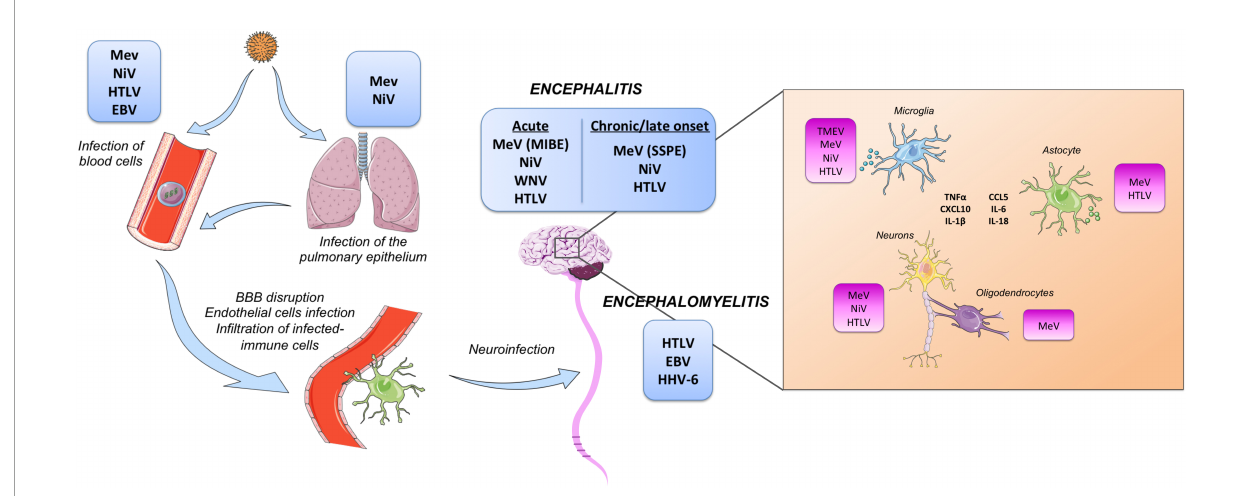
FIGURE1 Graphical representation of viral-induced neuroinflammation. (Left) Illustration of the route of infection through the nasopharyngeal route or blood fluids into the circulating system and the entry into the central nervous system (CNS) commonly by disruption of the blood-brain barrier (BBB). (Right) Illustration with the main viruses infecting the different CNS resident cells and the inflammatory response produced by oligodendrocytes, astrocytes, and microglia to viral infection.